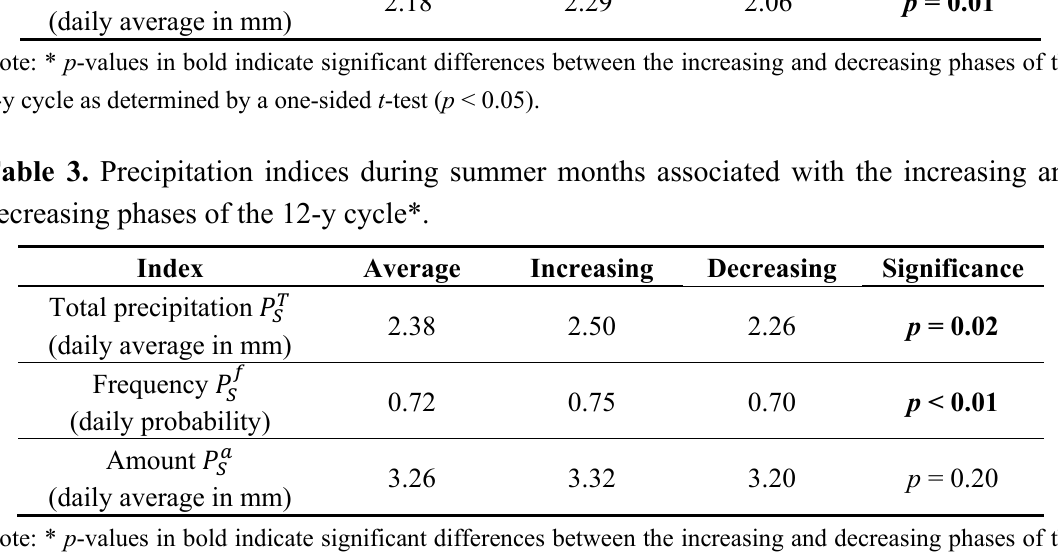
Table 2. Precipitation indices during winter months associated with the increasing and decreasing phases of the 8-y cycle*. Index Average Increasing Decreasing Significance Total precipitation (cid:1842) (cid:3050)(cid:3021) (daily average in mm) Frequency (cid:1842) (cid:3050)(cid:3033)